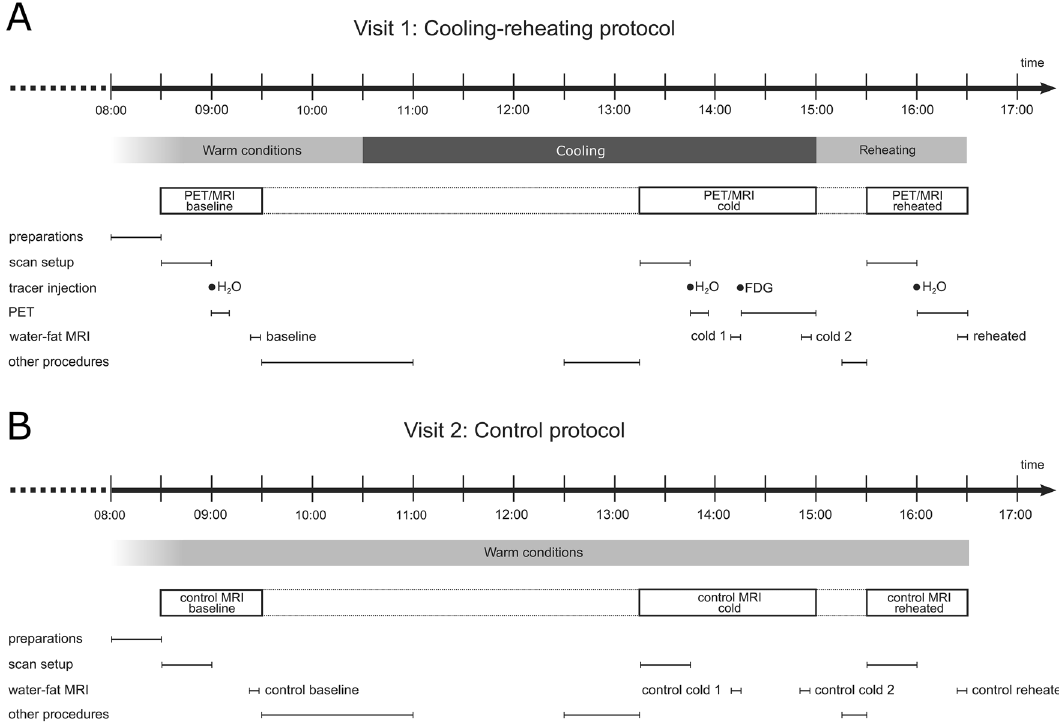
Figure 1. Schematic overview of the study protocols. (A) Cooling-reheating protocol and (B) Control protocol. Timings of procedures are indicated. Other procedures denote measures not included in the present work. H 2 O denotes [ 15 O]water and FDG denotes [ 18